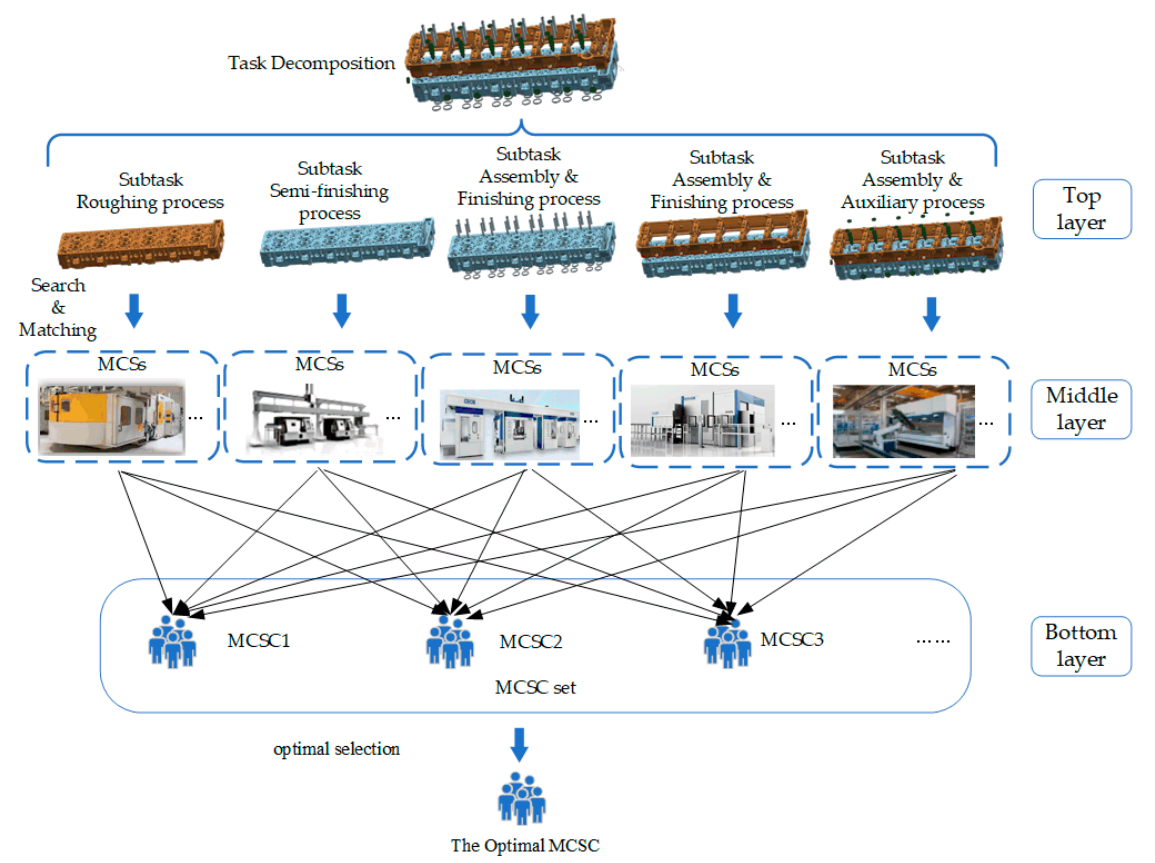
Figure 1. CMfg composition optimization mode of a certain type of natural gas cylinder head.